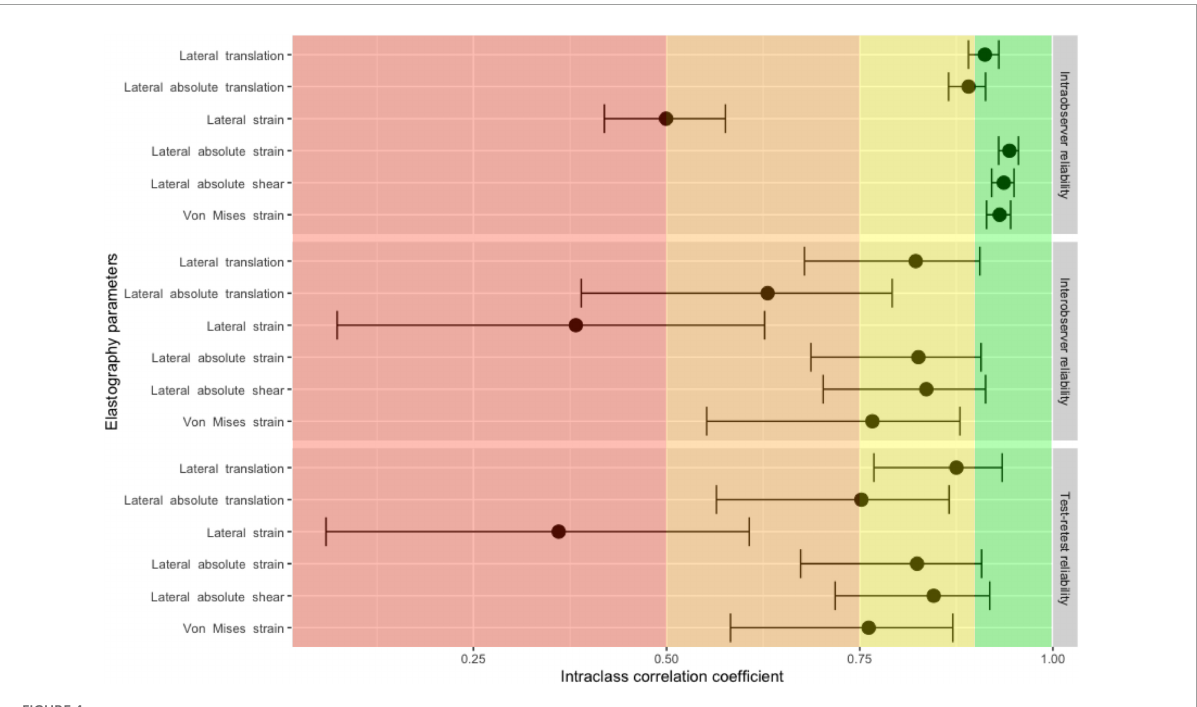
FIGURE4 Intraclass correlation coefficients and 95% confidence intervals for intraobserver, interobserver and test-retest reliability measures for elastography parameters. Intraclass correlation coefficients in the red panel indicate poor reliability, values in the orange panel indicate moderate reliability, values in the yellow panel indicate good reliability and values in the green panel indicate excellent